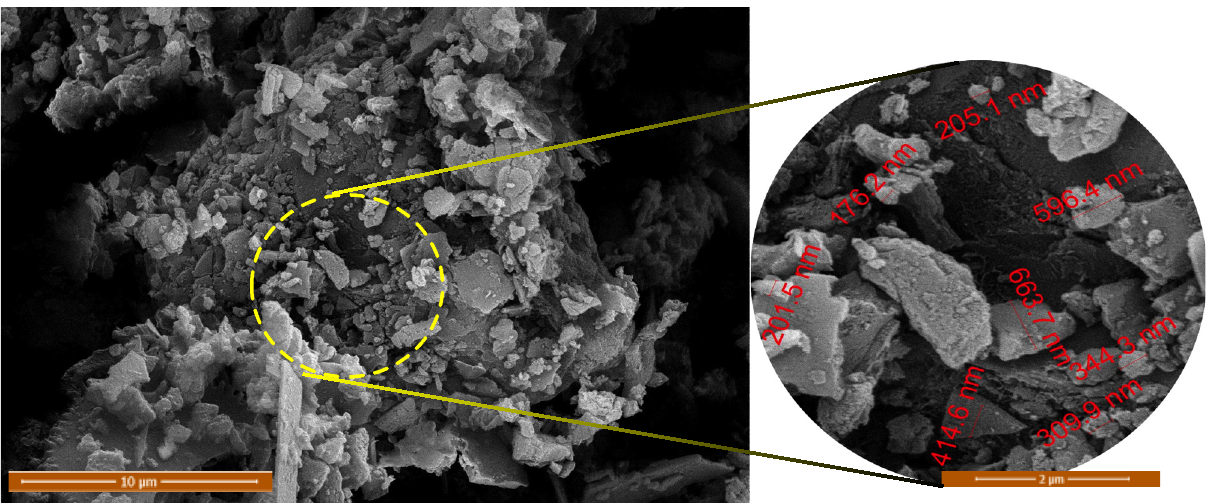
Figure 4. SEM images at different magnifications for the alum sludge granulated bed in constructed wetland systems (inset is 2 µm magnification with dimensions).